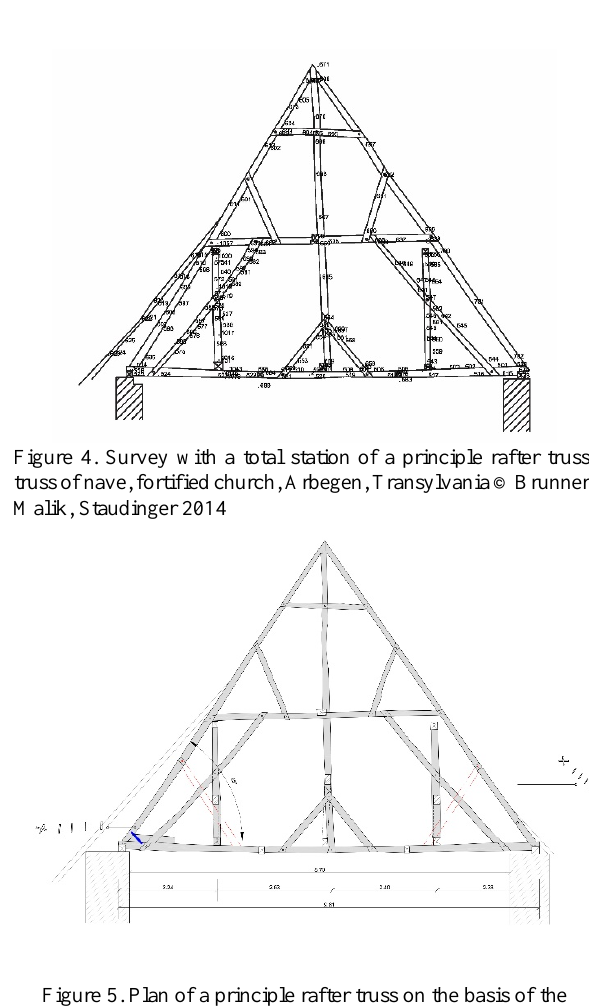
Figure 5. Plan of a principle rafter truss on the basis of the survey using total station and 3D laser scanner completed by hand measurements, truss of nave, fortified church, Arbegen, Transylvania © Brunner, Malik, Staudinger